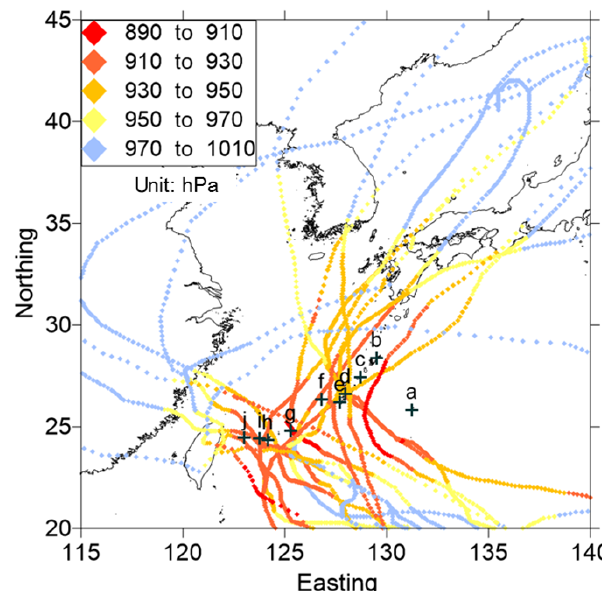
Figure 2. Tracks of the 17 selected tropical cyclones transiting over the ocean. The color differences represent the changes in central pressure. The crosses indicate the location of the 10 meteorologi- cal stations operated by the Japan Meteorological Agency (JMA): Minamidaito-jima (a) , Naze (b) , Okinoerabu (c) , Nago (d) , Naha (e) , Kume-jima (f) , Miyako-jima (g) , Ishigaki-jima (h) , Iriomote- jima (i) , and Yonaguni-jima (j)